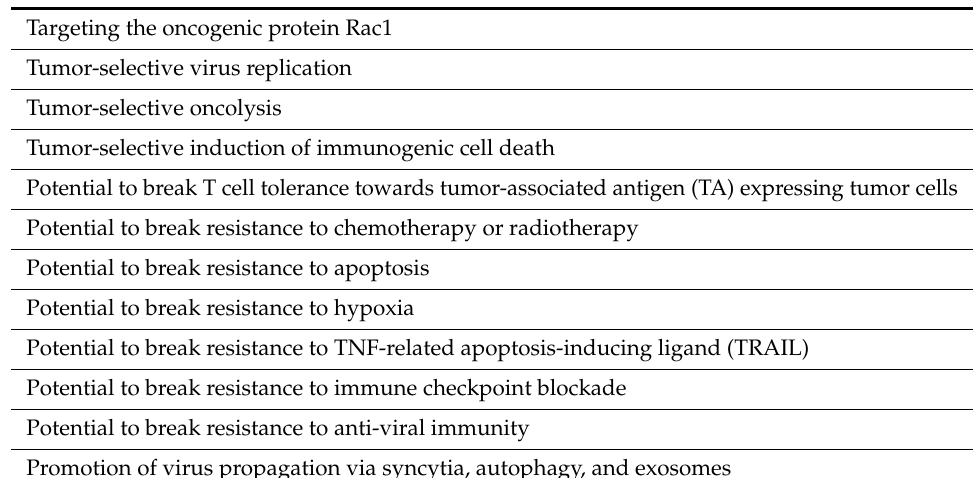
Table 2 contains a summary of the anti-neoplastic e ff ects of NDV. Table 2. Anti-neoplastic e ff ects of NDV in non-permissive